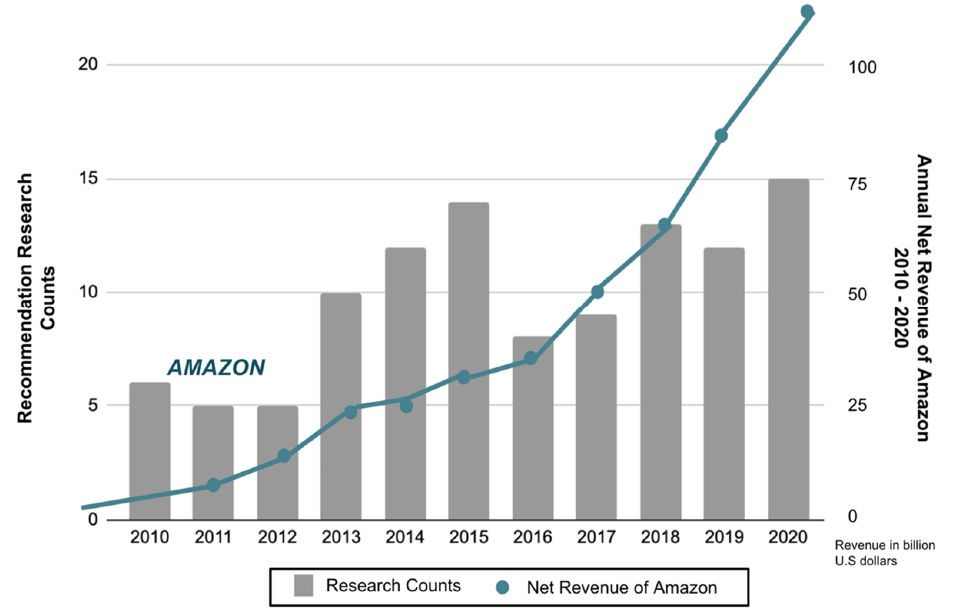
Figure 26. E-Commerce service field research trends from 2010 to 2021 and the number of users of Amazon, a representative service type of e-commerce service.